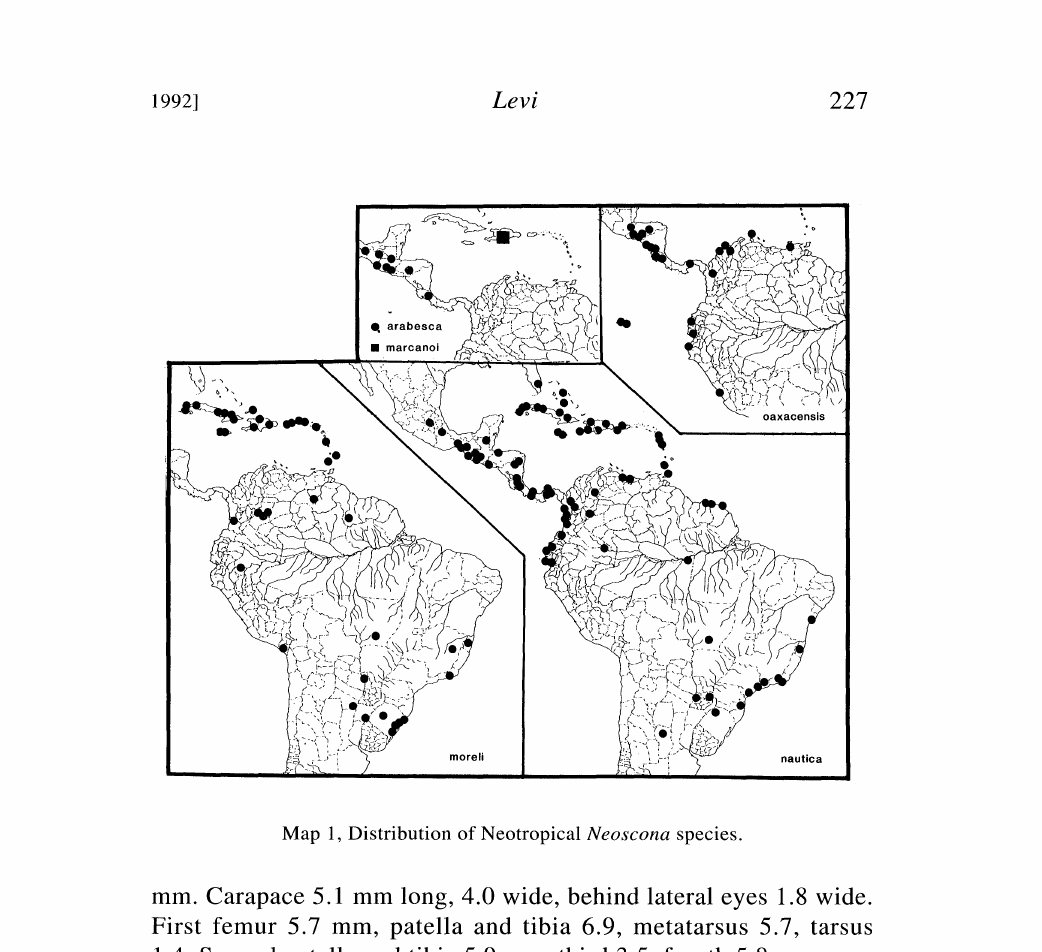
Map l, Distribution of Neotropical Neoscona species.